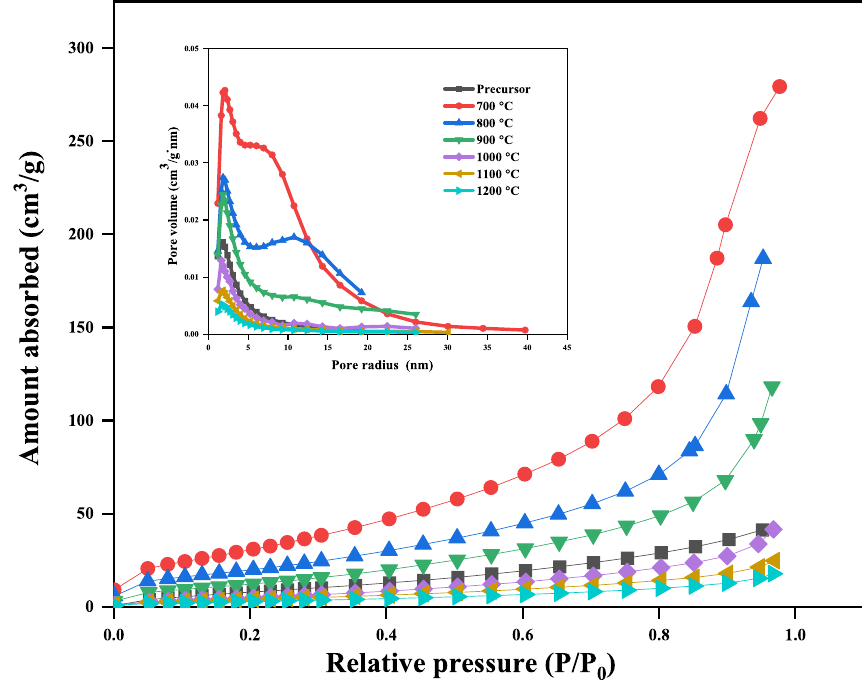
Fig. 8 Nitrogen adsorption isotherms and pore-size distri- bution curves of BeO nanofib- ers at each